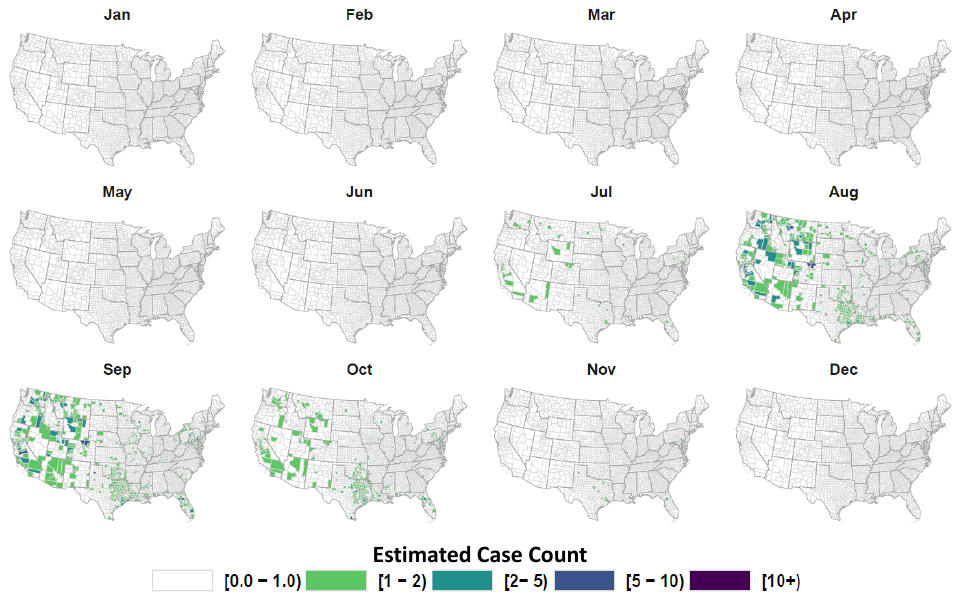
Figure A17. Estimated equine WND case counts. Maps depict the spatial and temporal distribution of model estimated WND cases by US County and month of year. Maps are color coded according to legend at bottom such that darker tones signify increased case loads and lighter tones represent relatively lower case